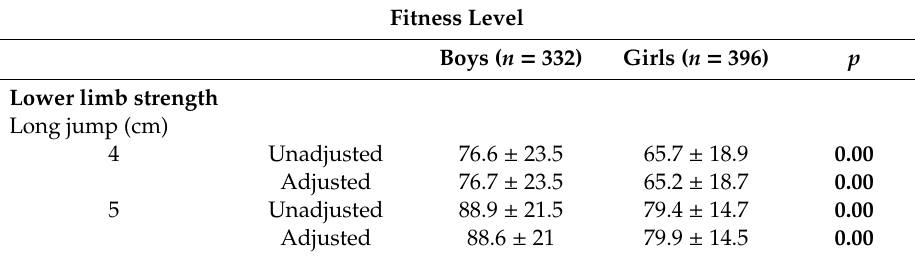
Table 2. Fitness level values (Mean ± SD), by age and